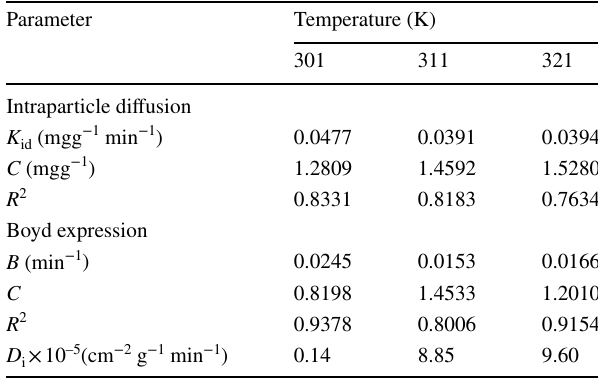
Fig. 10 Arrhenius plot for adsorption of CR dye on MSC